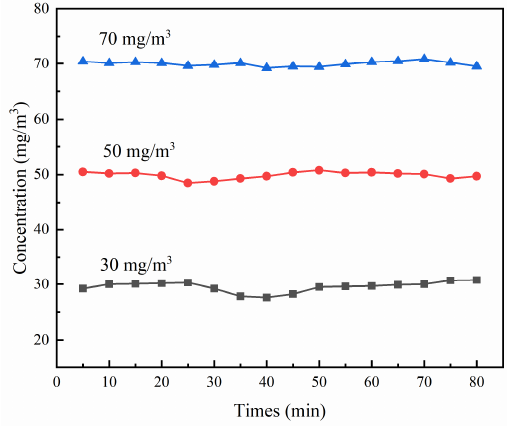
Figure 14. System stability test .